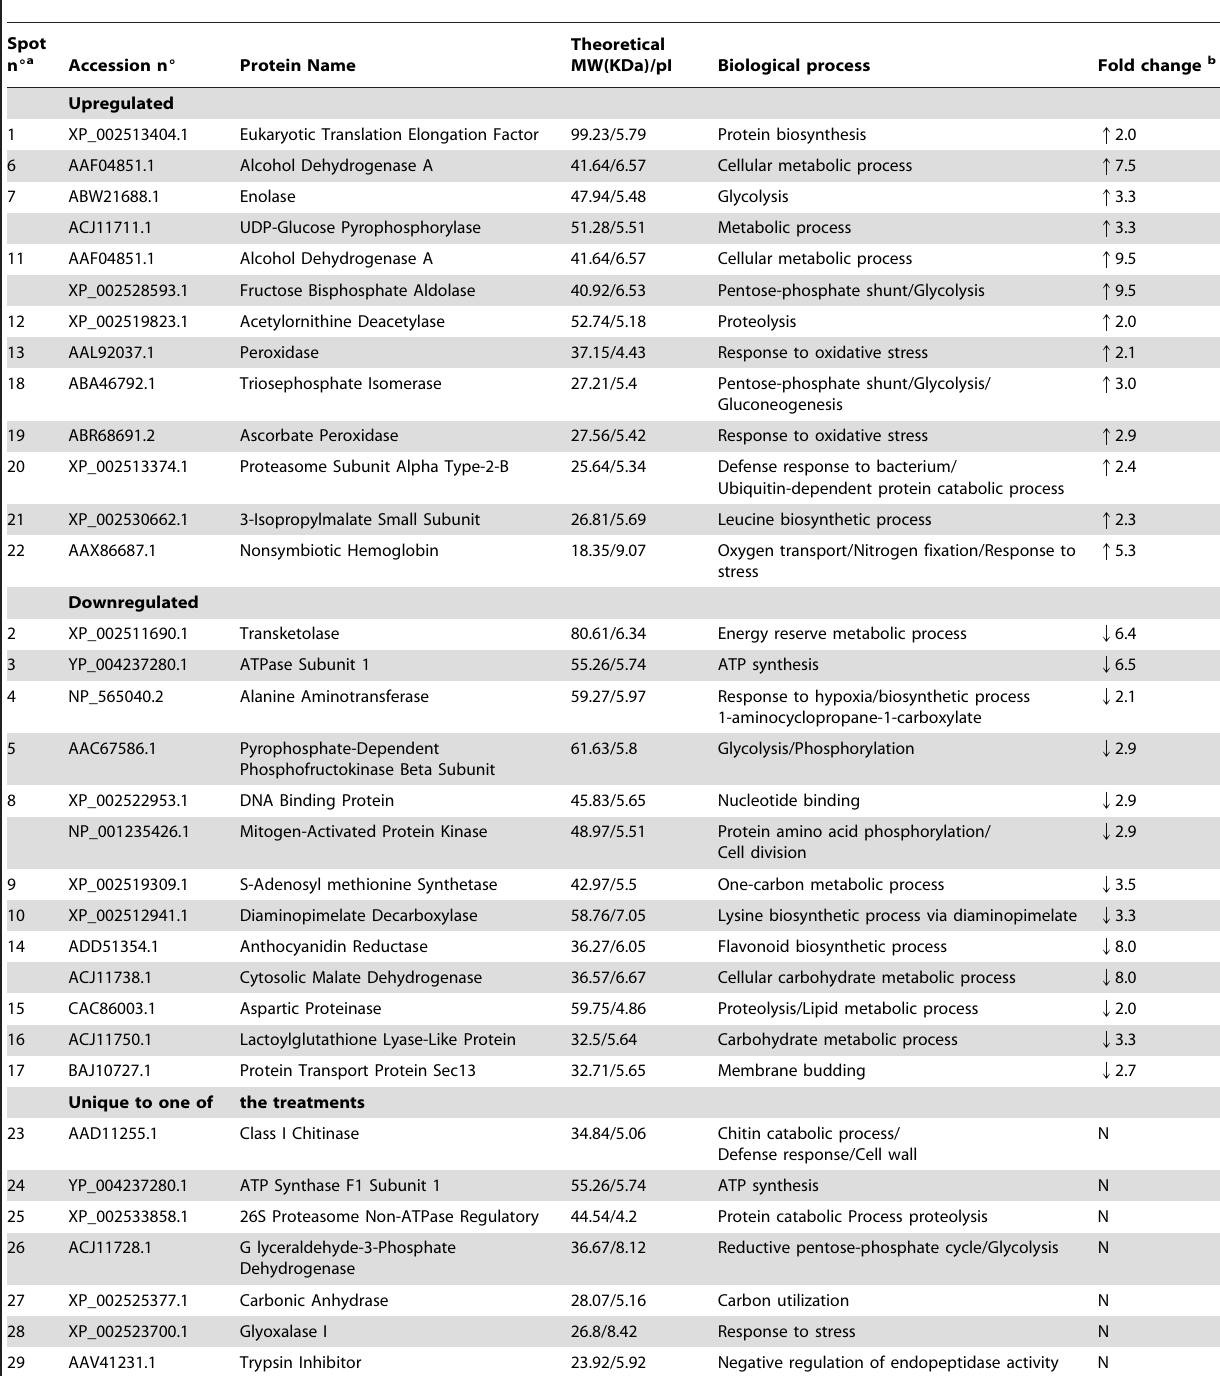
Table 2. Proteins from roots of the TSA-792 genotype of Theobroma cacao identified by mass